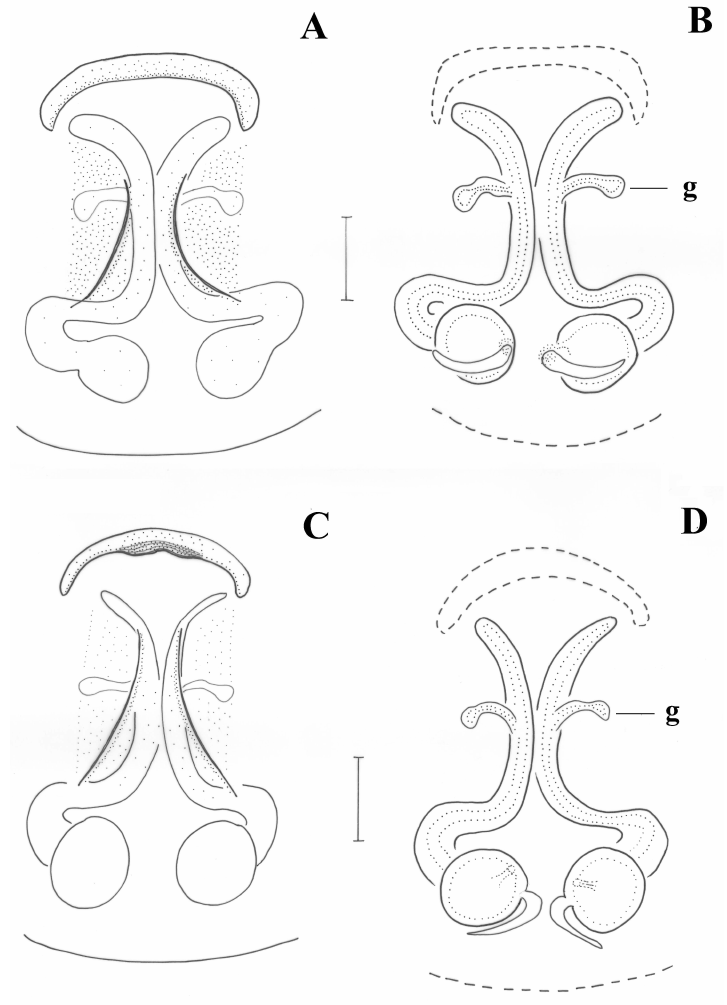
Figure 7. Drassyllus centrohellenicus n.sp. (paratype) ( A , B ) and Drassyllus dadianus n.sp. ( C , D ) (FC: 12148). ( A , C ) epigyne, ( B , D ) vulva. g: lateral gland. Type Material Holotype : male (NHMC, FC 9277). Magnisia, Kouri [39.1918 N 22.7436 E] low- leg. D. Kaltsas. Paratype: same—1 . ♀